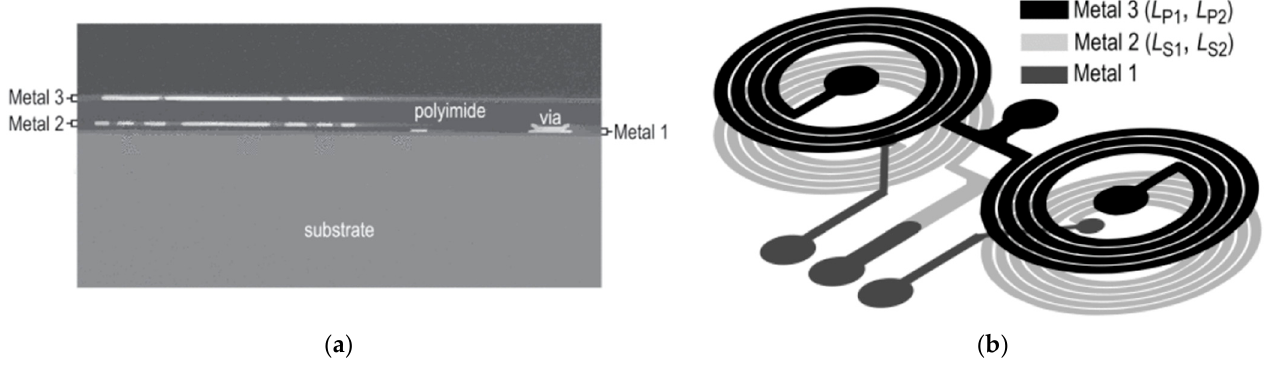
Figure 12. Isolation polyimide transformer ( a ) SEM cross-section ( b ) Layout view. Reproduced from [23]. Copyright 2020, IEEE.